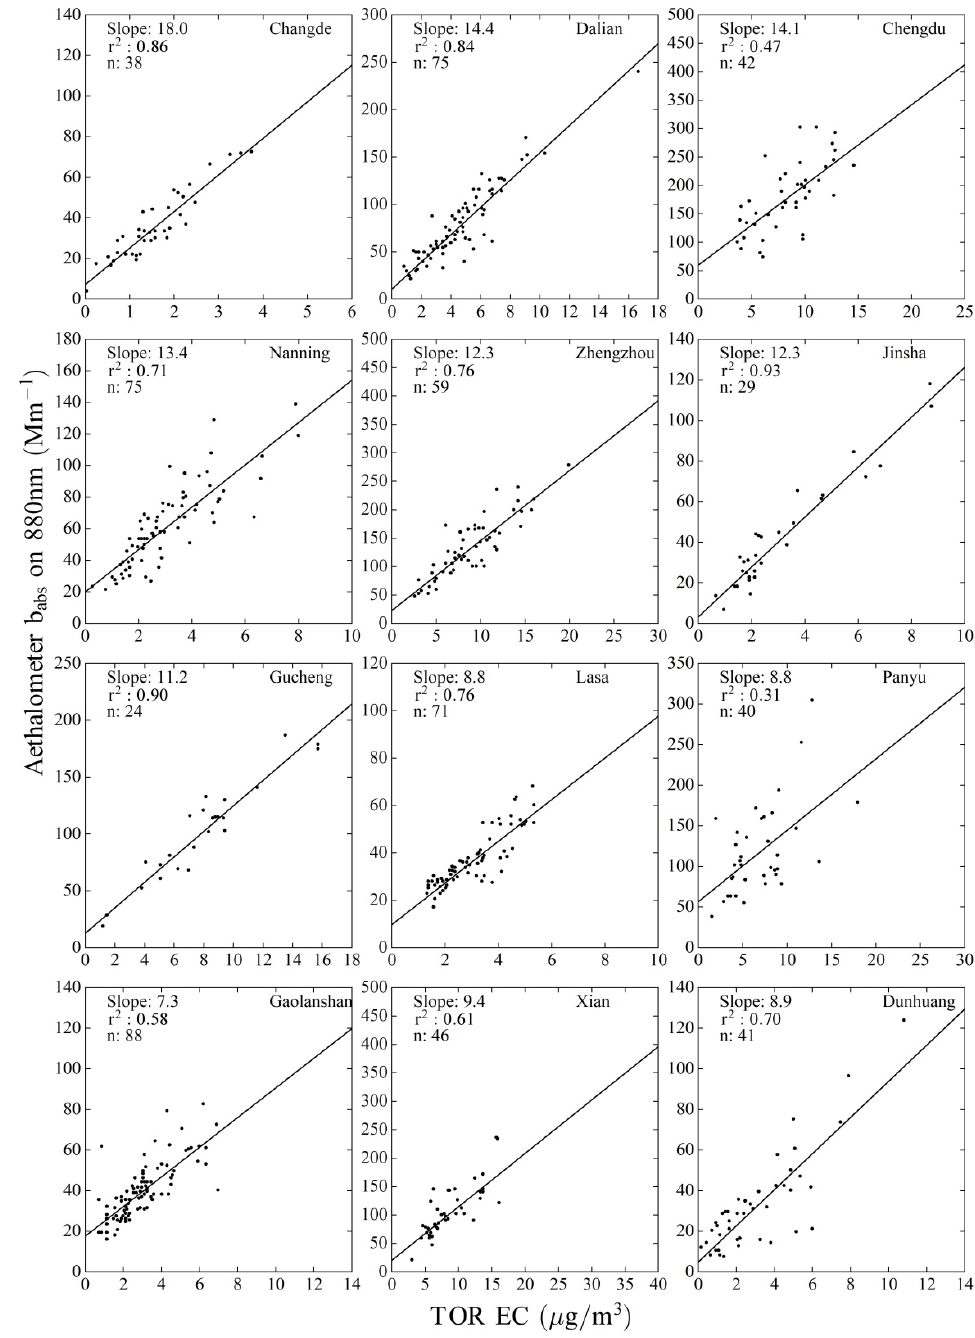
Figure 2. The correlations of absorption coefficient (common units: m − 1 or Mm − 1 = 10 − 6 m − 1 ) measured by Aethalometer and element carbon (EC) concentration.